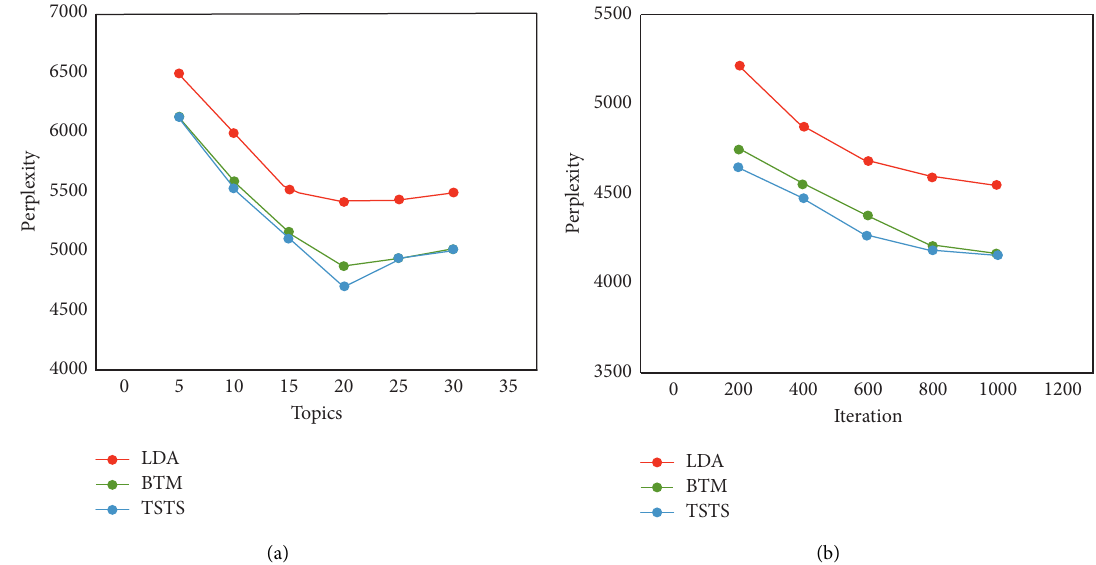
Figure 3: The relationship of the perplexity with the number of (a) topics and (b) iterations.